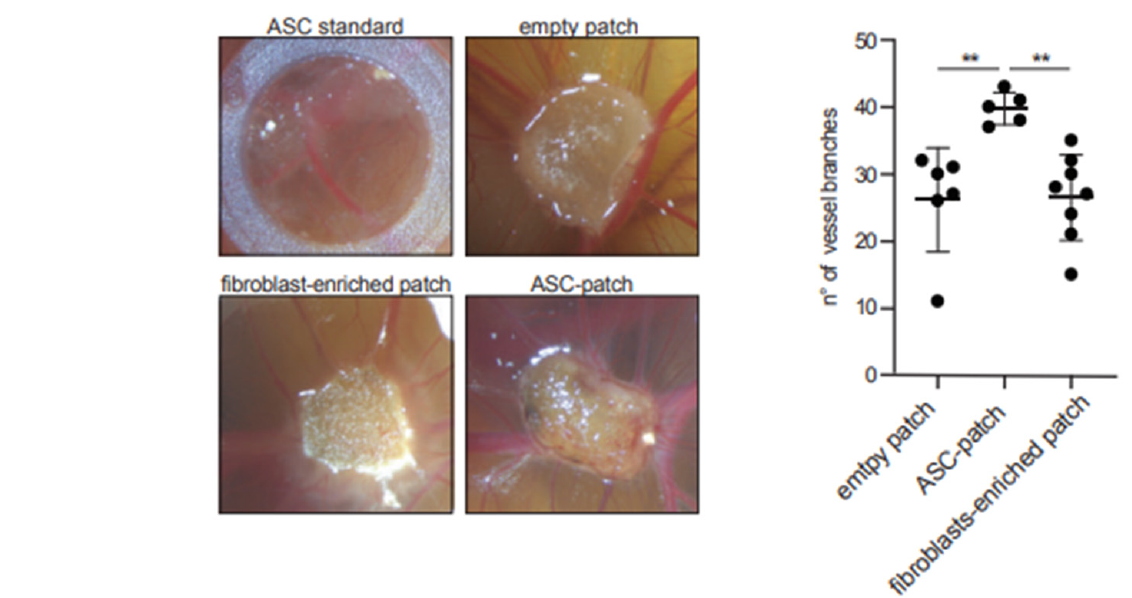
Figure 4. ASC-patch promotes neo-angiogenesis . ( A ) ASC-patches, fi broblast-containing patches, ASCs in single cell suspension (via a silicon ring) or empty gelatin sponges were deposited on the chorioallantoic membrane of fertilized chick eggs. Representative images of neovascularization are shown for each condition (left). The number of new vessels connections were quanti fi ed using ImageJ (right) (n = 6 assay). ( B ) A cell suspension of HUVEC was introduced in a Boyden chamber. Migration thorough a fi bronectin-coated hemipermeable membrane towards the indicated conditioned media was determined (n = 5 assays). ( C ) Assessment of tubulogenesis of HUVEC in the presence of the indicated conditioned media. Tube area was quanti fi ed by the Cytation 5 image analysis software. (n = 6 assay) ( D ) Representative image of tube formation in the indicated conditioned media. Overall, in the fi gure: mean ± SD; non-parametric Mann–Whitney t test: * = p < 0.05, ** = p < 0.01.